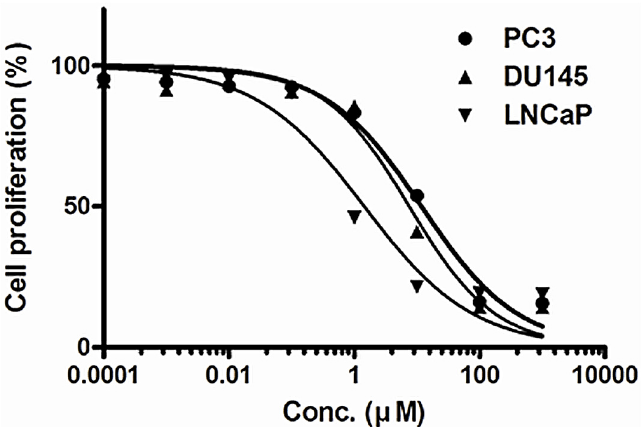
Fig 1. Growth inhibition of KML001 in prostate cell lines. Cells treated with various concentrations of KML001 were incubated for 72 h. The Alamar blue assay was done in triplicate. Mean values are given, the value of control being 100%. PC3 ( ● , thick solid line ), DU145 ( ▲ , thin solid line ), and LNCaP ( ▼ , thin solid line ).